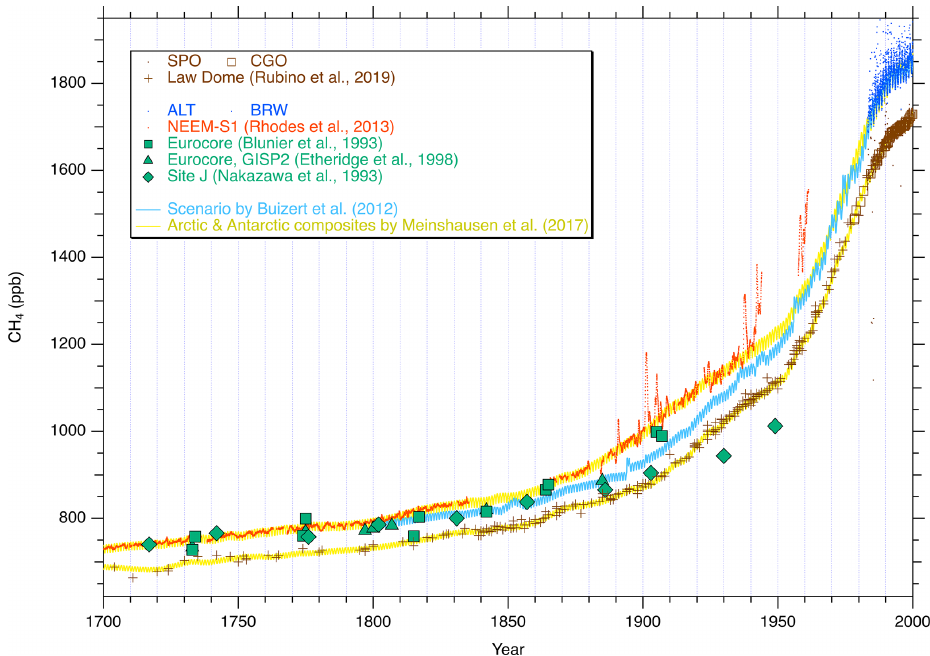
Figure 1. Atmospheric CH 4 mole fraction data covering the last 300 years. Symbols in brown are from the Southern Hemisphere; crosses and open circles are from the Law Dome ice core and firn, respectively (Etheridge et al., 1998; MacFarling Meure et al., 2006; Rubino et al., 2019). Open squares are from Kennaook / Cape Grim (CGO; MacFarling Meure et al., 2006), and dots are from the South Pole (SPO; ftp://aftp.cmdl.noaa.gov/, last access: 10 December 2021). Other coloured data (except for yellow) are from the Northern Hemisphere. Closed green squares, triangles, and diamonds are from the EUROCORE (Blunier et al., 1993), EUROCORE and GISP2 (Etheridge et al., 1998), and Site J (Nakazawa et al., 1993) ice cores. Red dots are the NEEM-S1 ice core (Rhodes et al., 2013), blue dots are from Alert, Canada (ALT), and Barrow, Alaska (BRW; ftp://aftp.cmdl.noaa.gov/), and light blue and yellow lines are the atmospheric scenarios prepared for the NEEM firn modelling (Buizert et al., 2012) and the CMIP6 experiments (Meinshausen et al., 2017), respectively. For the latter, Arctic and Antarctic scenarios with higher and lower mole fractions are shown,